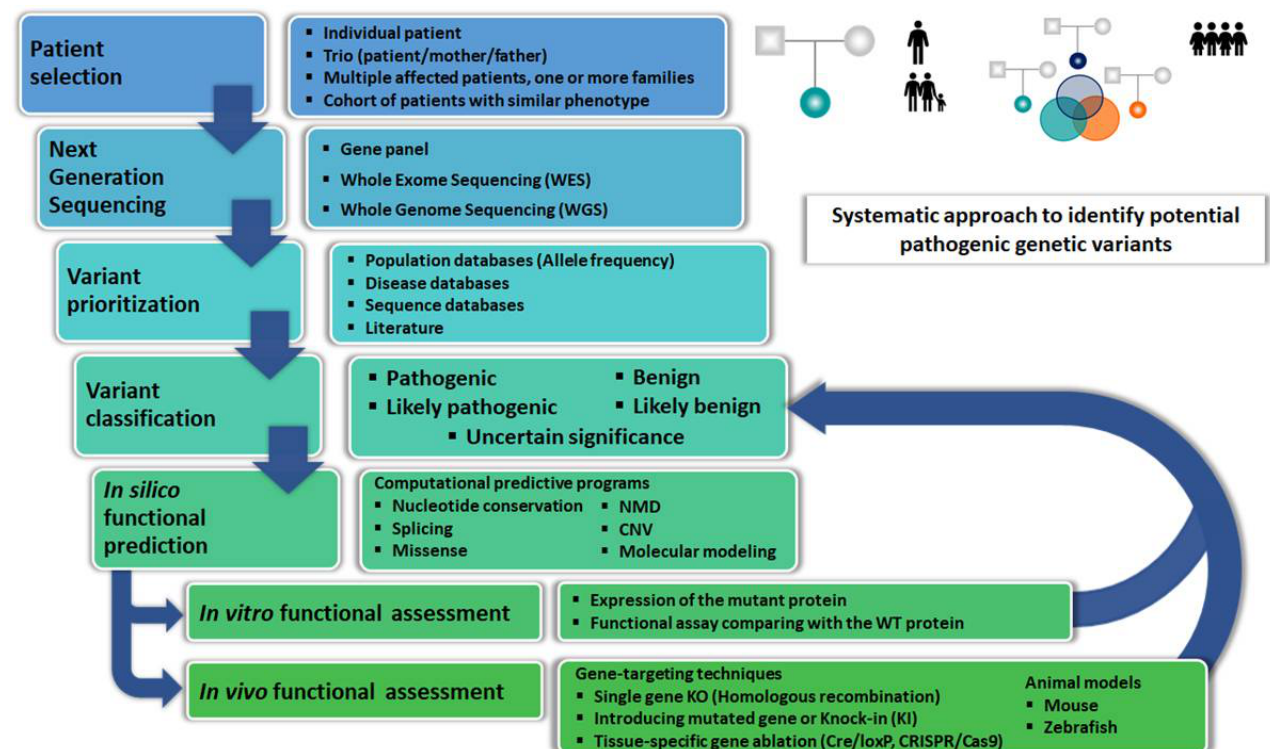
Figure 1. Systematic approach to identify potential pathogenic genetic variants. Flowchart for a systematic approach to select and characterize potential pathogenic genetic variants in children with growth and development disorders. The selection of patient(s) can be directed to individual patients, a trio including the patient and his/her parents, multiple families presenting several affected index cases, or a cohort of patients sharing a similar phenotype. Next-Generation Sequencing (NGS) can be performed using gene panels, Whole Exome Sequencing (WES), or Whole Genome Sequencing (WGS). For variant(s) prioritization, population, disease, and sequence databases are used. Systematic literature review is also required. Variants are then classified according to ACMG criteria as pathogenic, likely pathogenic, of uncertain sig- nificance, likely benign, or benign. In silico functional assessment is based upon several computational predictive pro- grams. Finally, to unequivocally determine the pathogenicity of a novel genetic variant, further in vitro functional assays and sometimes in vivo animal models are required.